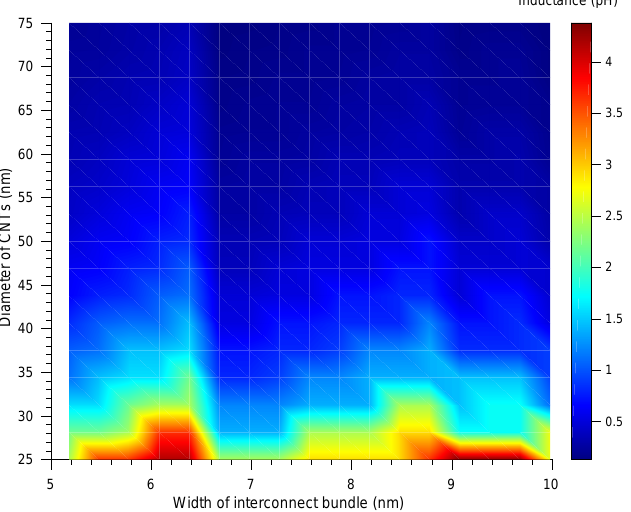
Figure 3. Concurrent extraction of inductance of the squarely packed bundle of mixed CNTs by varying the width of the bundle and the diameter of the